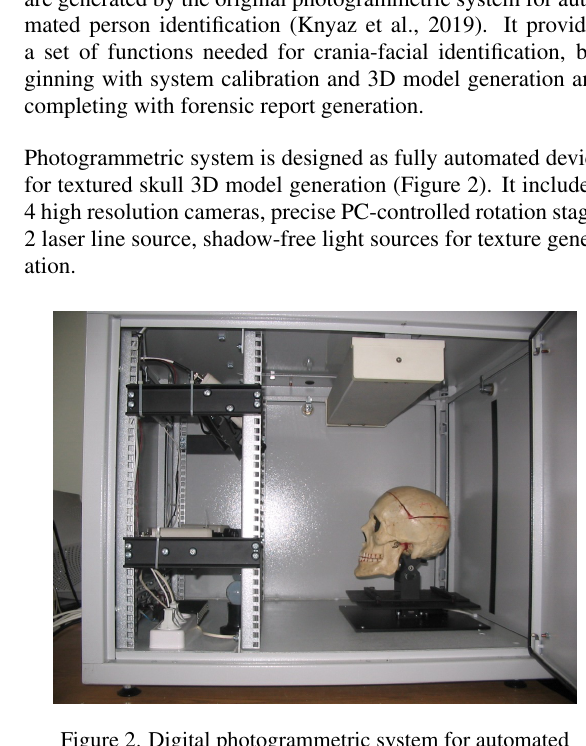
Figure 2. Digital photogrammetric system for